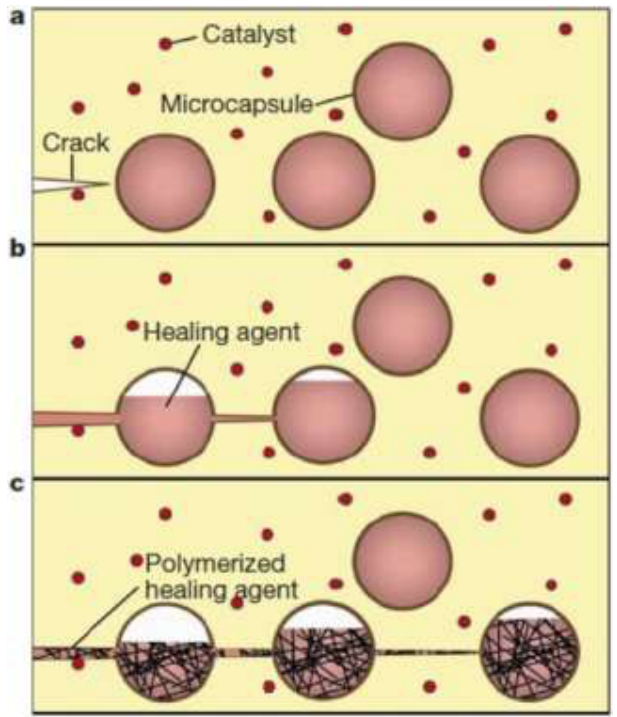
Figure 3. The concept of autonomous cure micro-capsules. ( a ) crack breaks the rooted mi-cro-capsules ( b ) healing agent discharge into crack surfaces ( c ) causing polymerization and the neighboring cracks to plug.